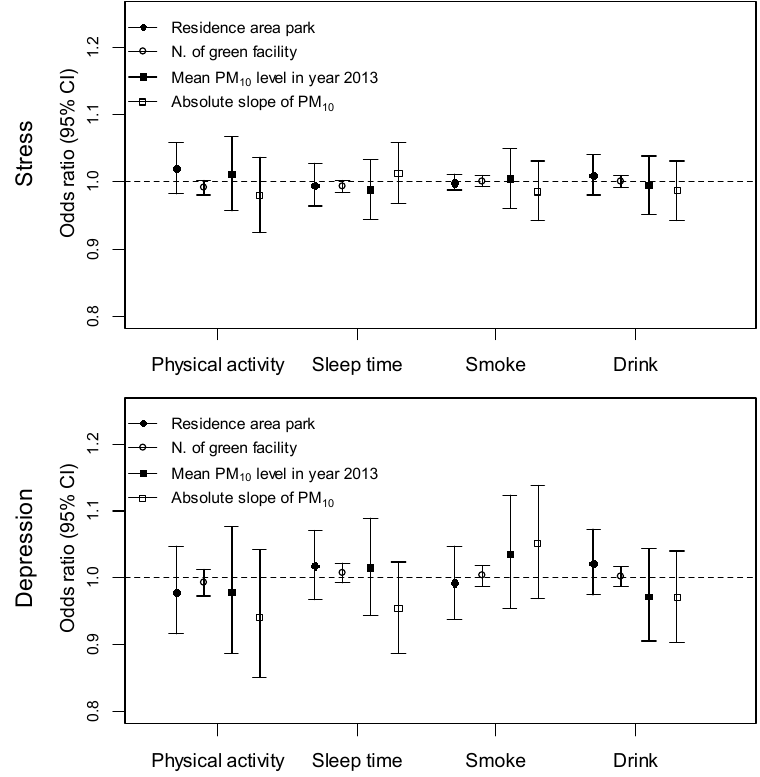
Figure 2. Effect modification between individual health behavior and community based environments are presented. The modification was estimated using interaction terms and the reference groups of physical activity, sleep time, smoke, and drink are less than 2 days of physical activity during a week, less than 6 h of sleep in a day, currently not smoking, and currently not drinking, respectively. Odds ratio (OR) with 95% confidence interval (CI) was estimated for each environment with certain unit increases; residential area park (3 m 2 ), number of green facilities (5 units), annual mean level of PM 10 (2 µg/m 3 ), and absolute slope of PM 10 (0.1 unit).